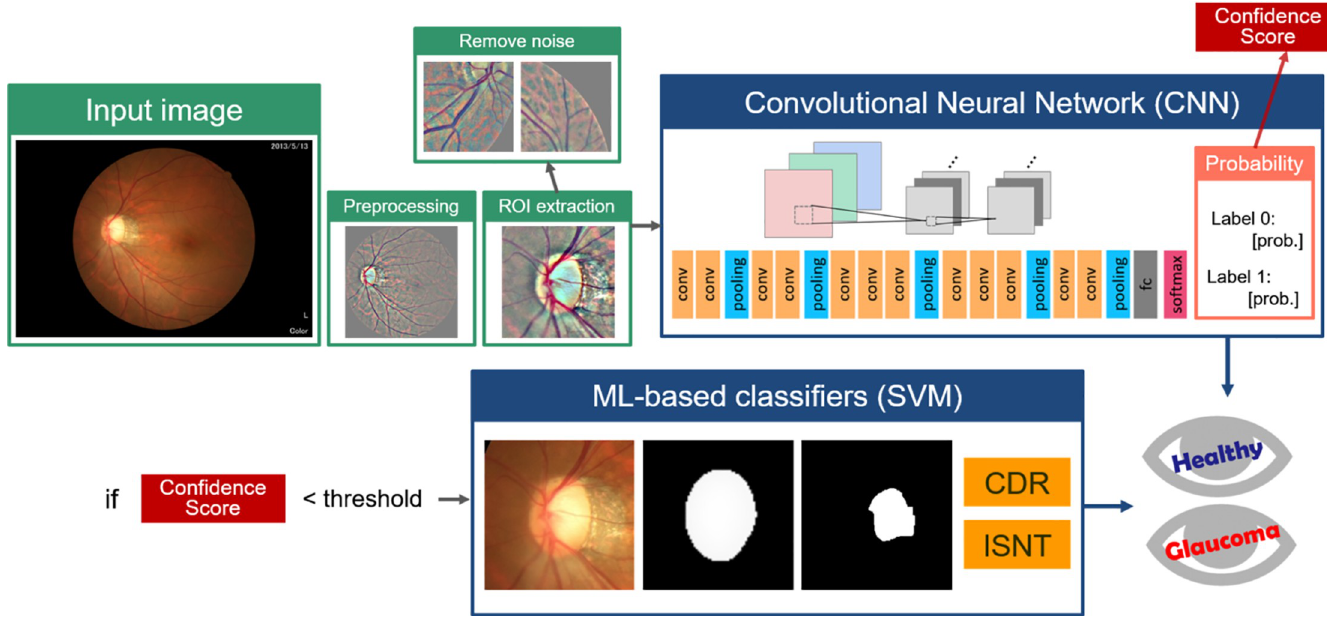
Fig 1. Overall Framework. Original color images were preprocessed to contrast the vessels and then submitted for ROI extraction. Image with incorrect ROI selection, referred as noise, were excluded from the CNN model. Images with low confidence score in CNN classification were forwarded to an ML-based classifier based on the key characteristics of CDR value and thinning of the superior and inferior neuroretinal rim according to the ISNT rule. CDR, cup-to- disc ratio; CNN, convolutional neural network; ML, machine-learning; ROI, region of interest; SVM, support vector machine.